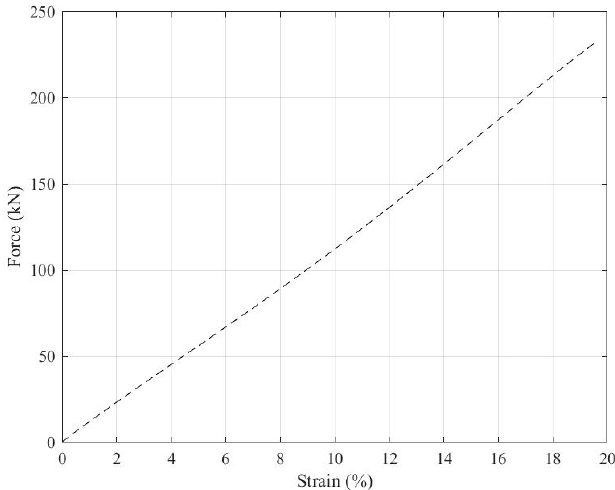
Figure 15. Modelled tensile force-strain behaviour of hybrid rope up to failure.